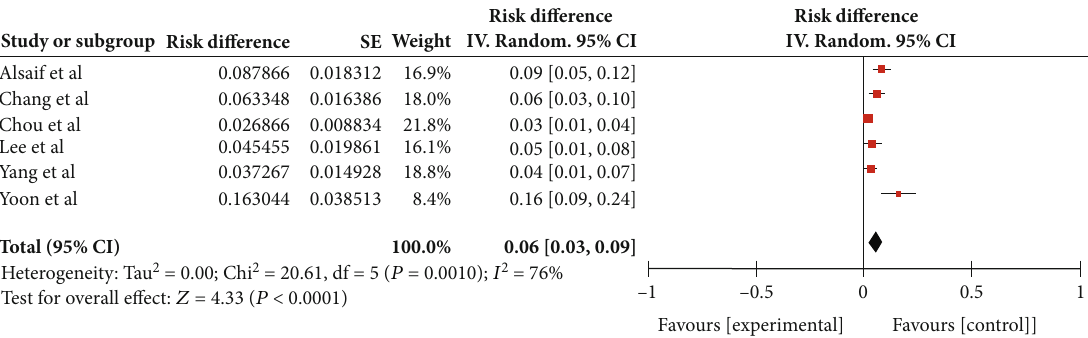
Figure 2: The incidence of septic pulmonary embolism (SPE) in patients with Klebsiella pneumoniae liver abscess (KPLA). A pooled estimate of the incidence of SPE in patients with KPLA revealed that the overall incidence was 6% (95% CI, 3% – 9%). There was considerable and signi fi cant heterogeneity ( p < 0 : 01 , I 2 = 76 %